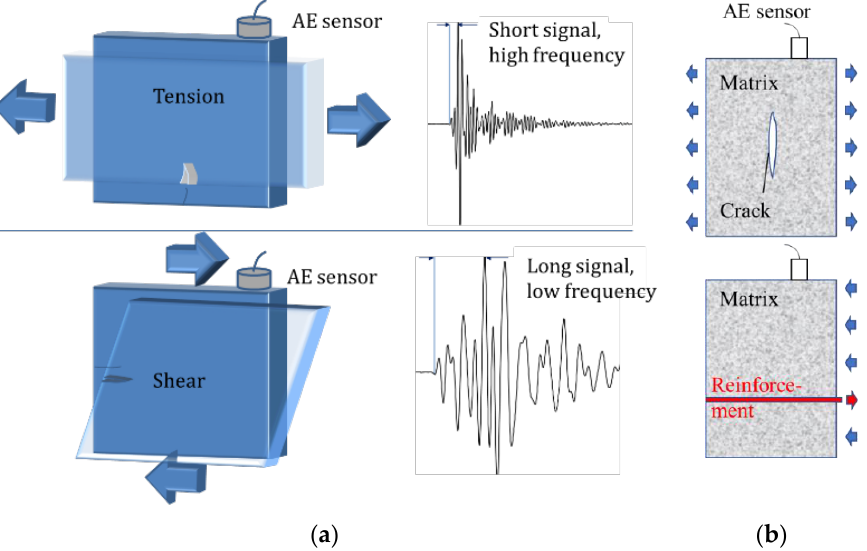
Figure 1. ( a ) Correspondence between stress mode and AE waveform, ( b ) illustration of typical tensile (top) and shear (bottom) events in reinforced concrete.